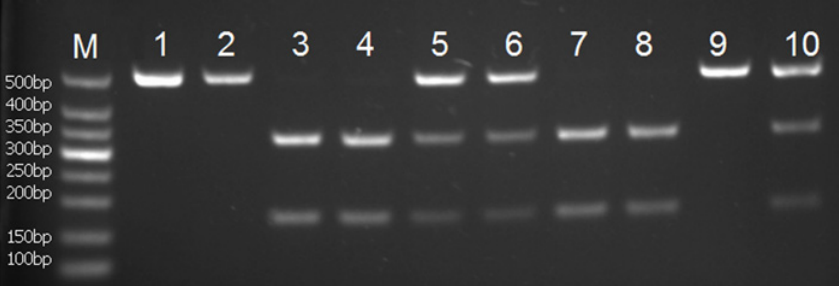
Figure 2. PCR-RFLP assay for analyzing the rs1543297 polymorphisms of the osteocalcin gene. Lanes M: DNA Marker; Lanes 1, 2 and 9 show CC genotype; lane 5, 6, and 10 shows CT genotype; Lanes 3, 4, 7 and 8 show TT